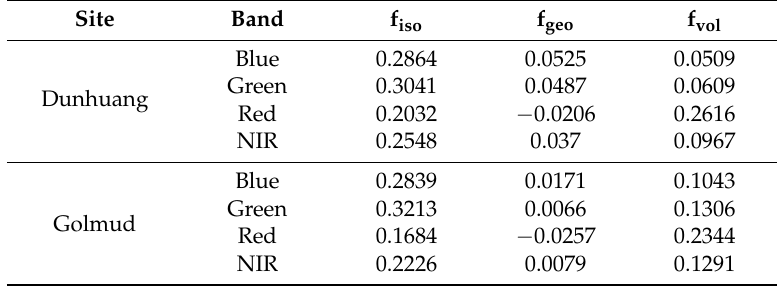
Table 3. BRDF model parameters based on the MODIS TOA reflectance over the Dunhuang and Golmud test site. Site Band f iso f